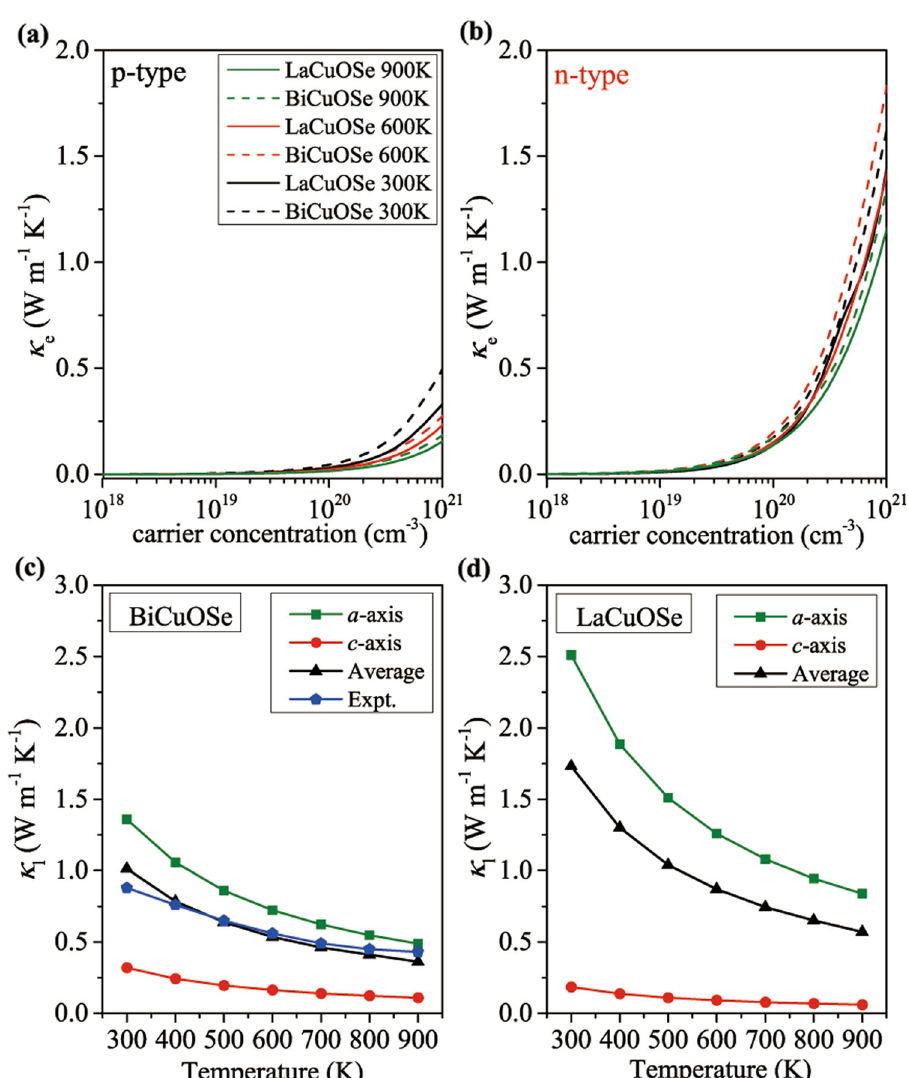
Fig. 5 Thermal transport property. The electronic thermal conductivities ( a , b ) for BiCuOSe and LaCuOSe as a function of carrier concentration. c The lattice thermal conductivities for BiCuOSe and LaCuOSe as a function of